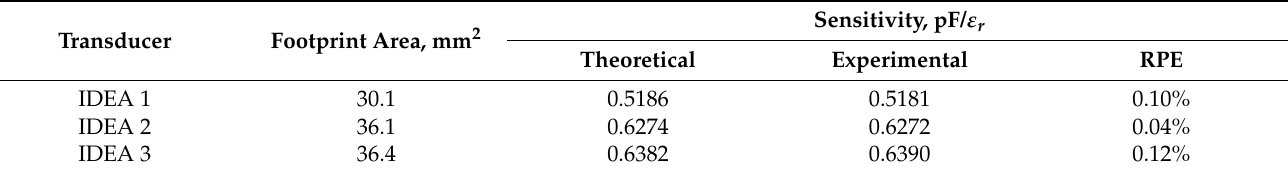
Table 4. Sensitivity relative percentage error between theoretical calculations and experimental results. Sensitivity, pF/ ε r Transducer Footprint Area, mm 2 Theoretical